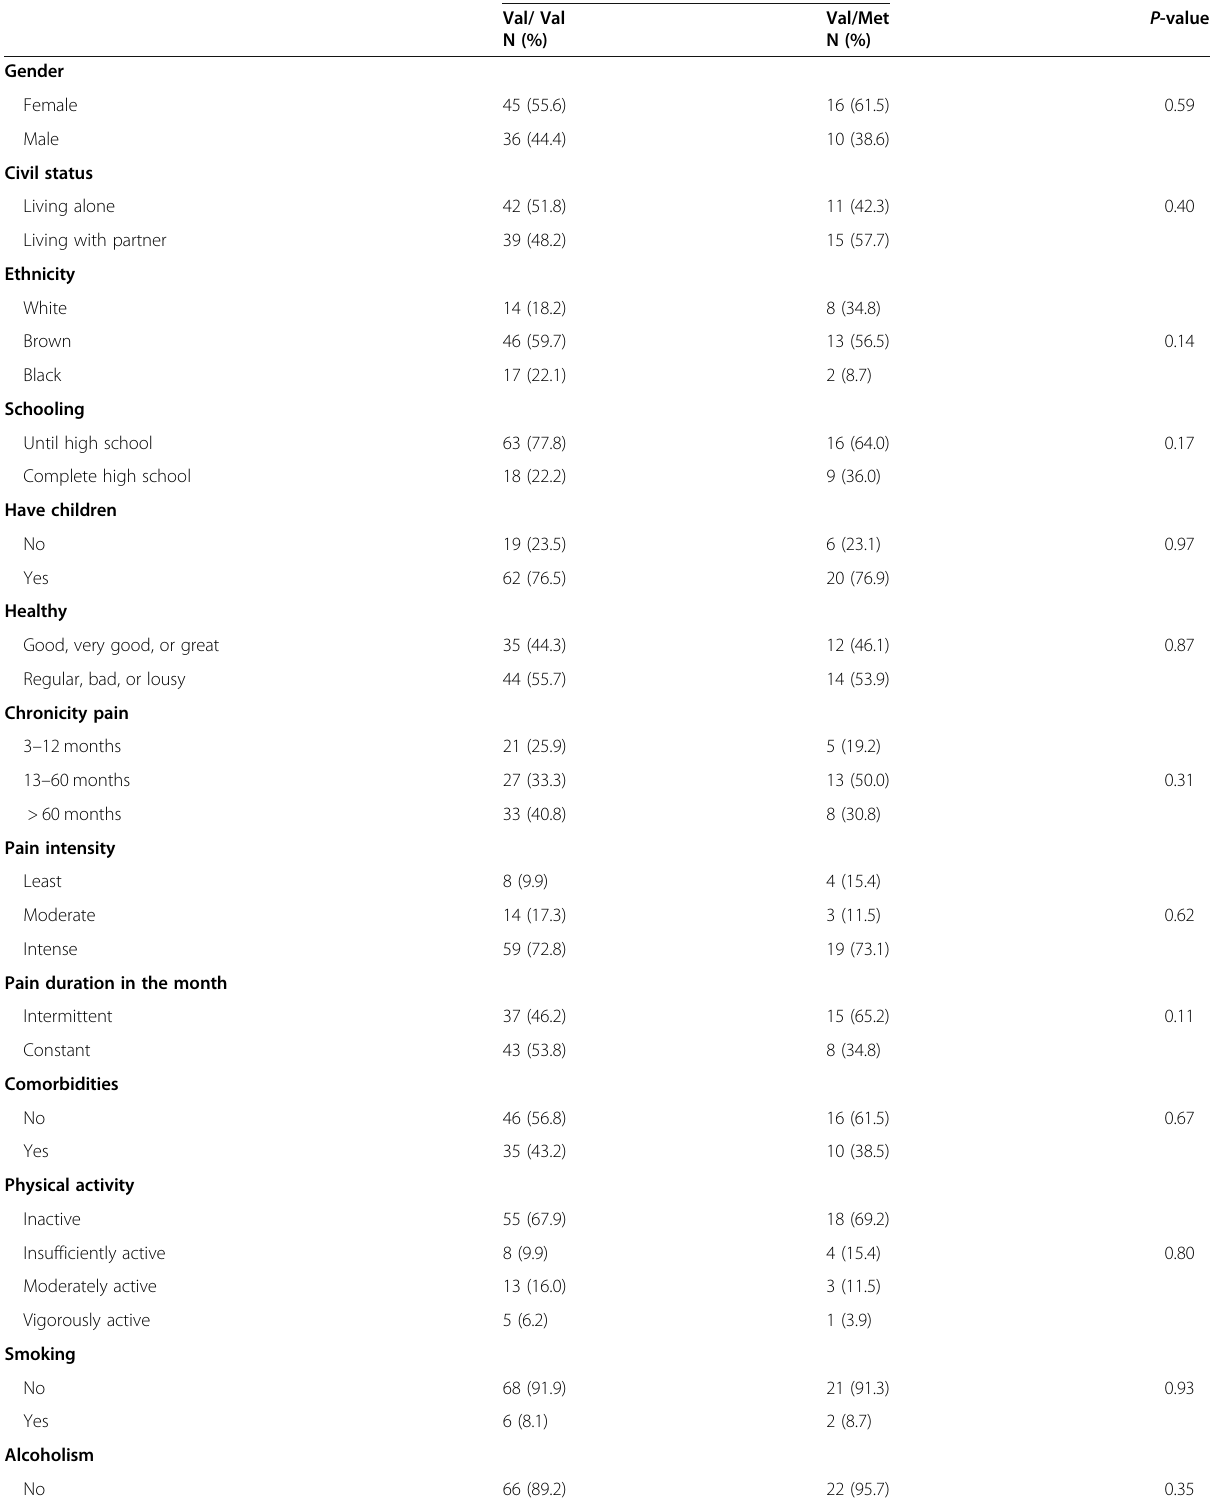
Table 3 Comparison of the qualitative variables according to the BDNF Val66Met